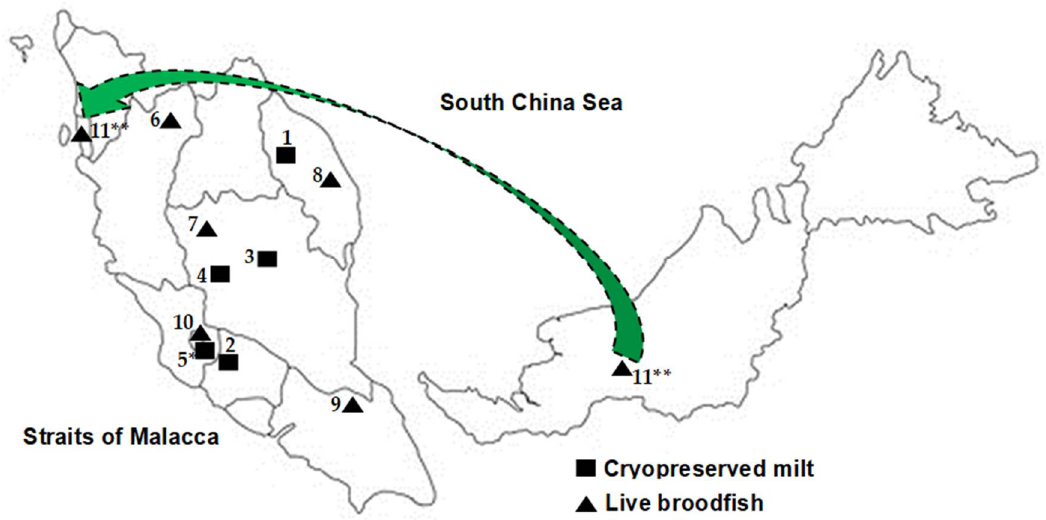
Table 1. The Malaysian mahseer samples used for microsatellite genotyping in this study.